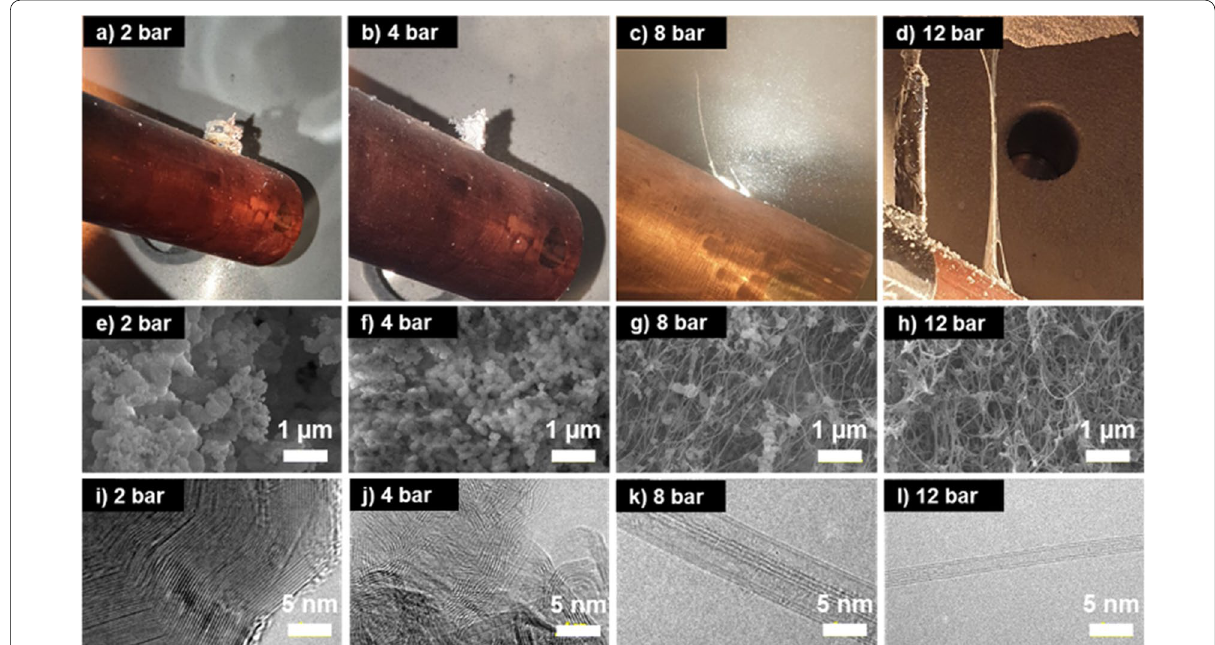
Fig. 3 a – d Form, ( e – h ) morphology and i – l structure images of reaction products at 2, 4, 8 and 12 bar when the chamber is full of N2. BNNTs were dominant product at 8 and 12 bar and h‑BN was dominant product at 2 and 4